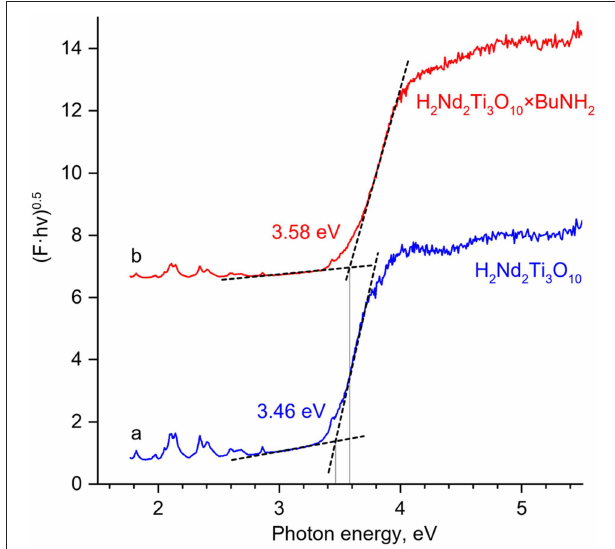
FIGURE 7 | The Tauc plots for H 2 Nd 2 Ti 3 O 10 (a) and H 2 Nd 2 Ti 3 O 10 × BuNH 2 (b) based on diffuse reflectance measurements. The Kubelka-Munk function F is plot against the photon energy h ν in the coordinates (F · h ν ) 0.5 – h ν . The bandgap energy is determined from the cross point of linear sections.